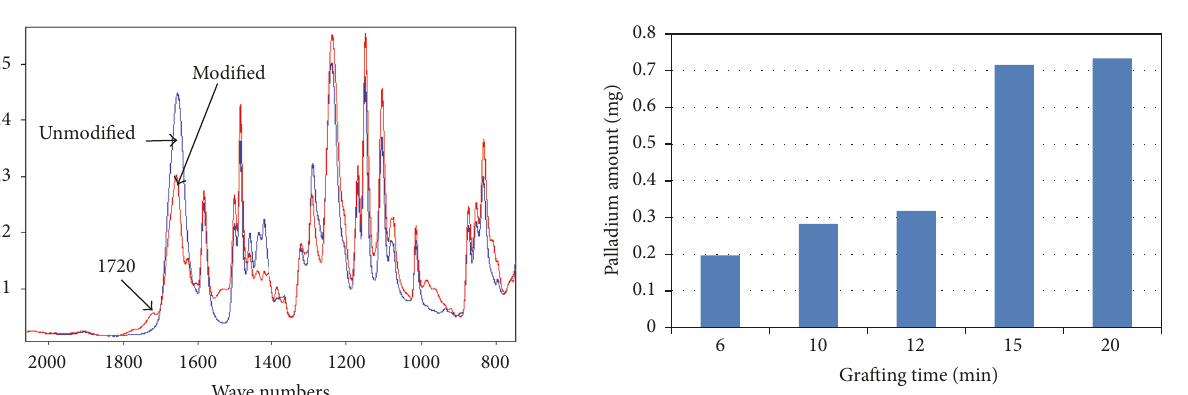
Figure 3: The ATR-FTIR spectra of unmodified and modified PES flat sheet membranes using UV grafting of AA (25 wt%) at 20 min UV batch irradiation time.